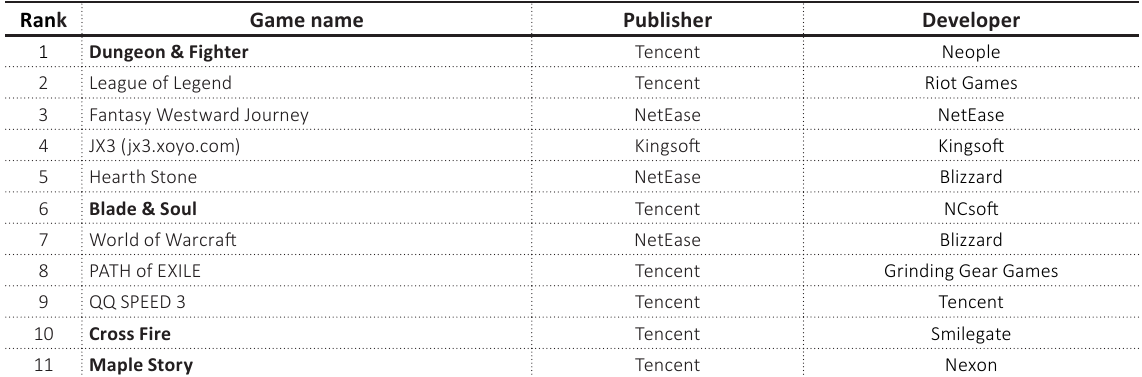
Table 2. 2018 rank of PC games in